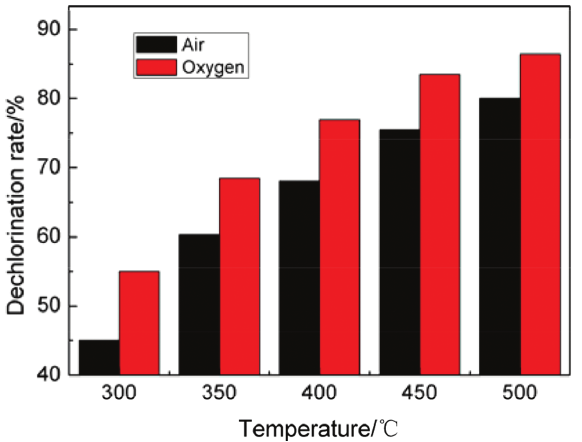
Figure 3: The dechlorination rate of CuCl residue after conventional